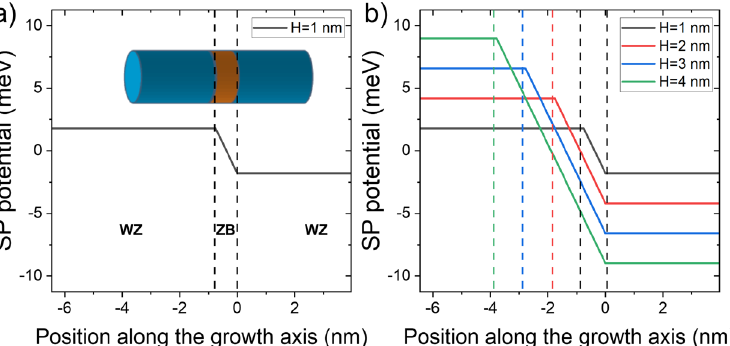
3 2 C/m ) potential profile along nanowire [111]